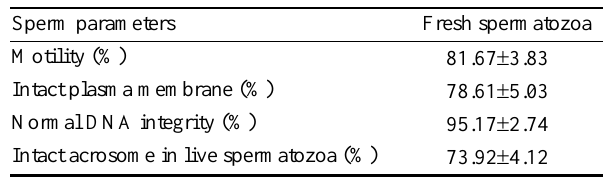
Table 1. Characteristics of fresh cauda epididymal